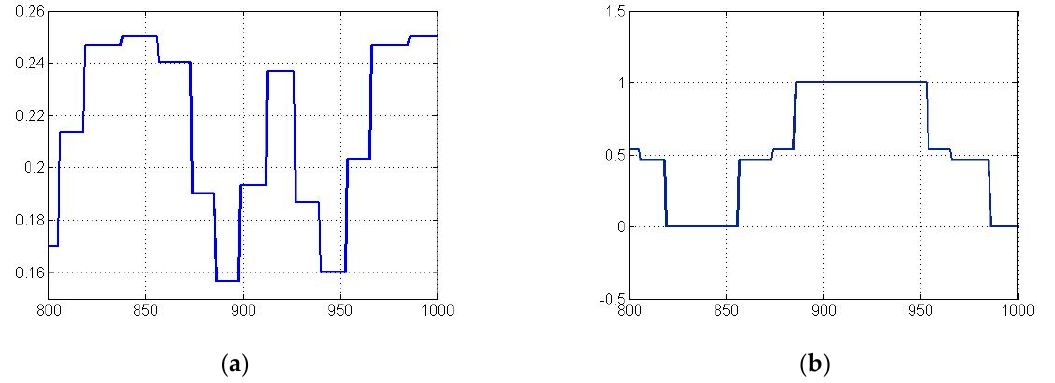
Figure 4. Initial useful signals with rectangular pulses at the inputs of transmitter: ( a ) useful signal a(t) ; ( b ) useful signal c(t) .